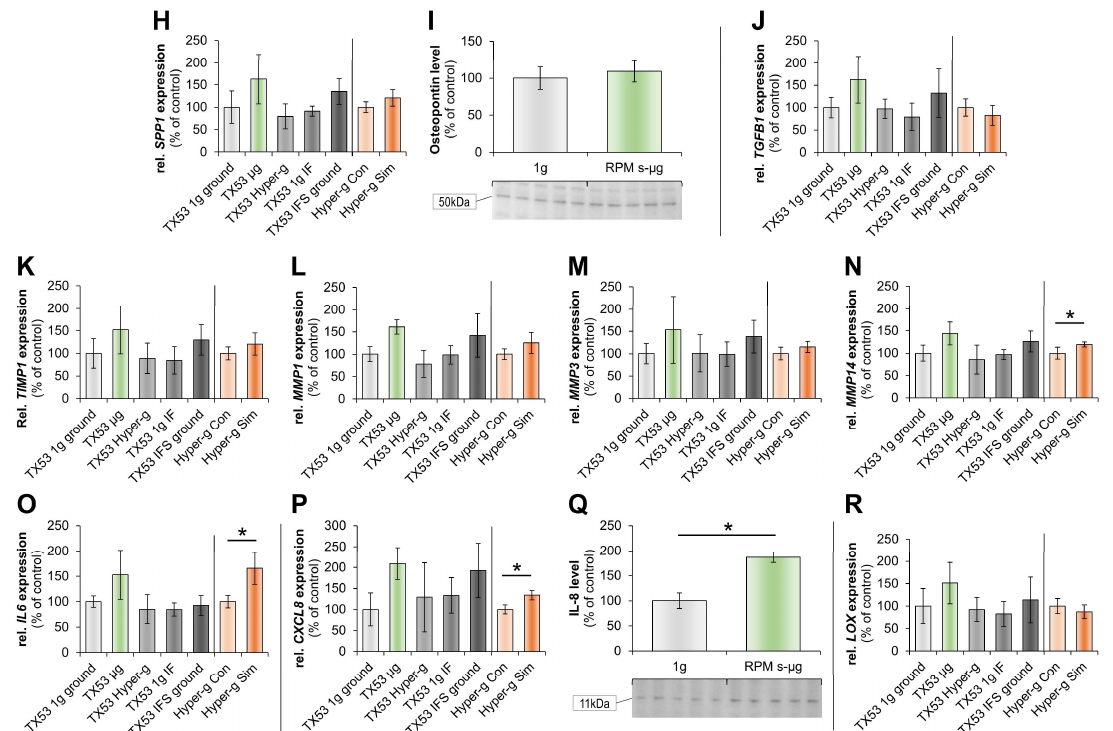
Figure 3. IFS of fibronectin (green) and nucleus (blue) ( A , B ); scale bar 10 µm; red arrow redistributed fibronectin, qPCR analyses of FN1 ( C ), Col1A1 ( E ), Col4A5 ( F ), SPP1 ( H ), TGB1 ( J ), TIMP1 ( K ), MMP1 ( L ), MMP3 ( M ), MMP14 ( N ), IL-6 ( O ), CXCL8 ( P ) and LOX ( R ), and WB of fibronectin ( D ), collagen